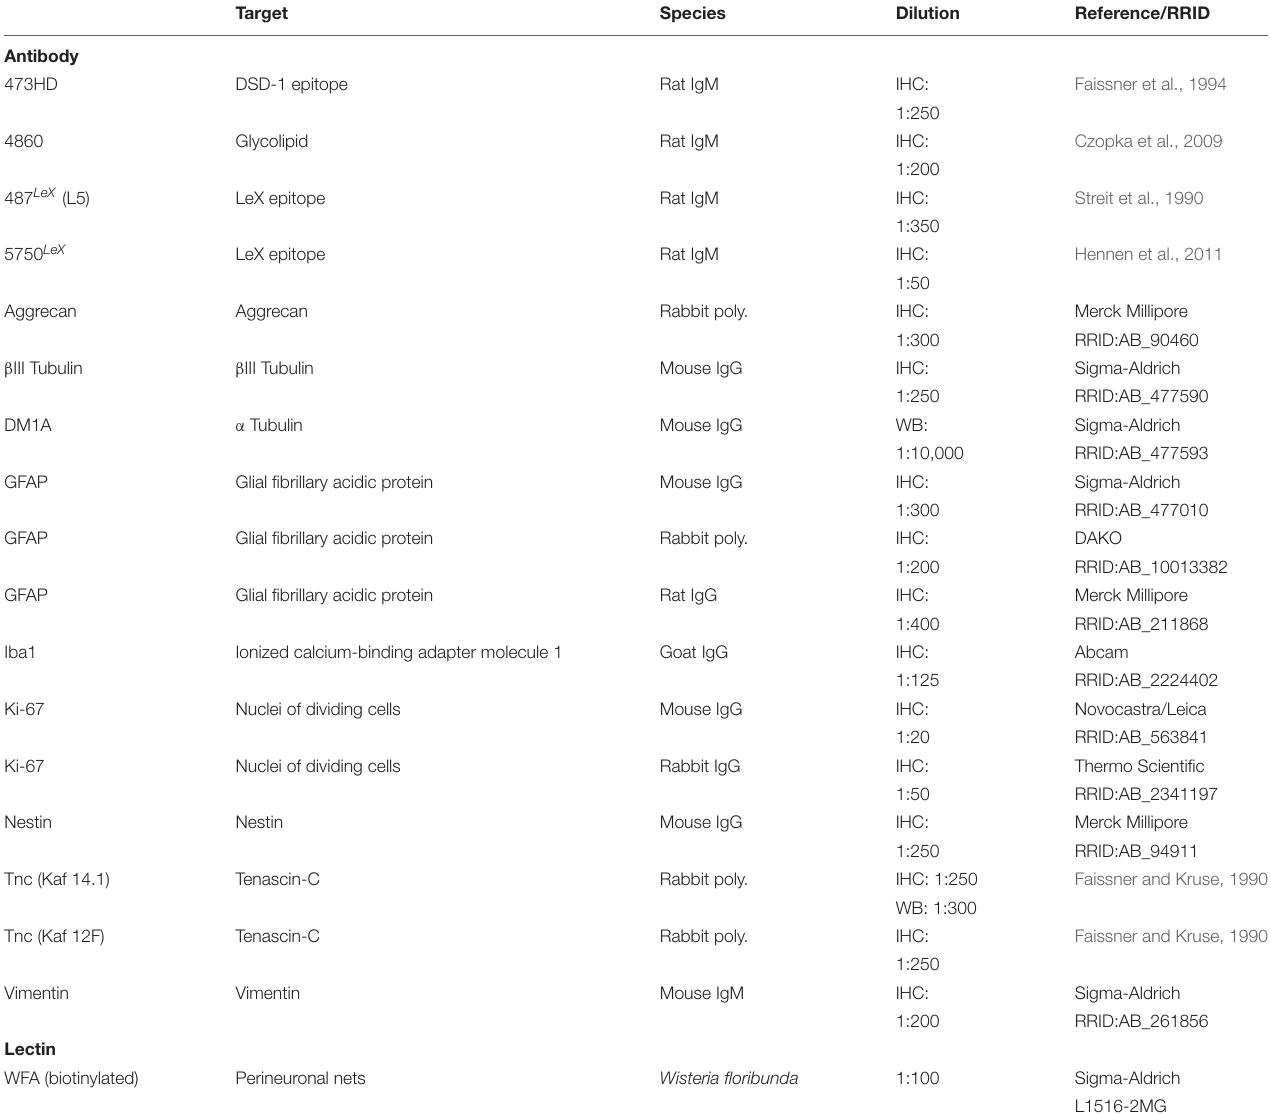
TABLE 1 | Primary antibodies used for immunohistochemical analysis (IHC) and Western Blot (WB). Target